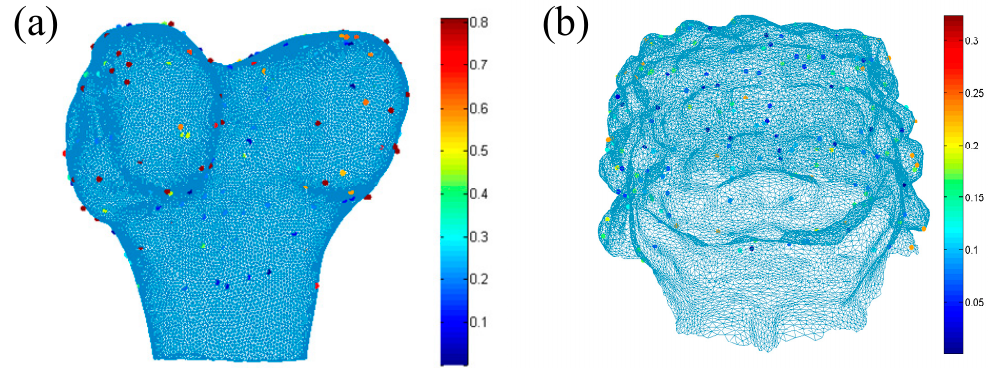
Figure 13. Diagram illustrating ( a ) the actual error evaluation of knee bone, ( b ) the actual error evaluation of Chinese lion model (units: mm).